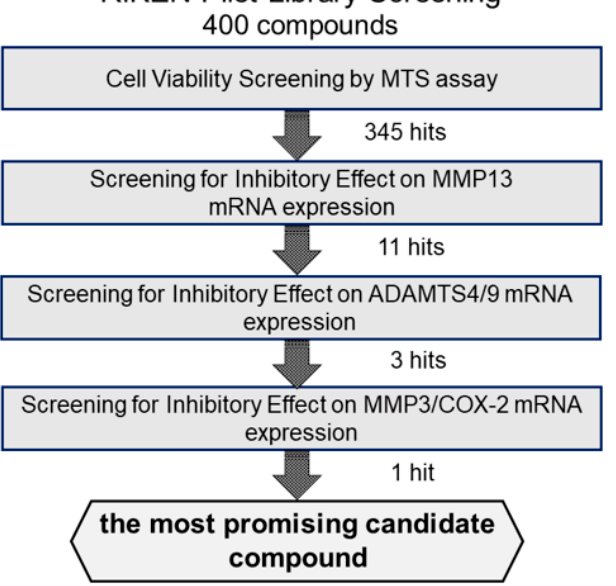
Figure 1. Schematic representation of the strategy for screening the candidate compounds. To evaluate the cytotoxicity of candidate compounds, OUMS27 cells were treated with 10 µ g/mL each test compound for 24 h, followed by an MTS assay for cell viability estimation ( n = 3 or n = 5). Among the 400 test compounds we began with, 345 had the least cytotoxic effects compared to the untreated cells ( p < 0.05). We next screened these 345 compounds for their potential inhibitory effect on IL-1 β -induced MMP13 mRNA expression and selected 11 most effective compounds. Subsequently, we assessed the inhibitory effect of these 11 compounds on the IL-1 β -induced ADAMTS4 and ADAMTS9 mRNA expression along with MMP3 and COX-2 mRNA expression and finally selected the most promising candidate compound: (2-(8-methoxy-2-methyl-4-oxoquinolin-1-yl)-N-(3-methoxyphenyl)acetamide).